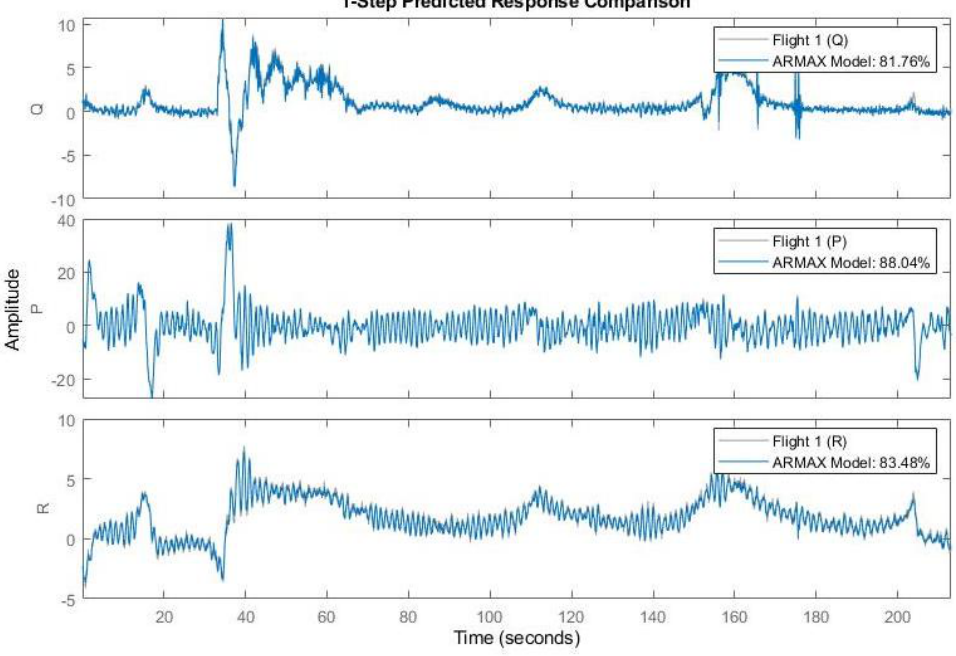
Figure 12. ARMAX Model